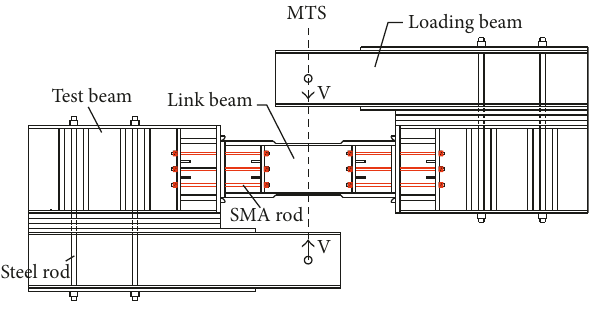
Figure 16: Virtual test setup.